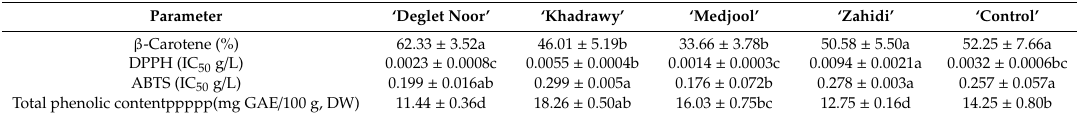
Values are mean ± SD of five samples per treatment and control with three independent determinations per sample. Means followed by same letter(s) in a row do not di ff er significantly at 0.05 probability